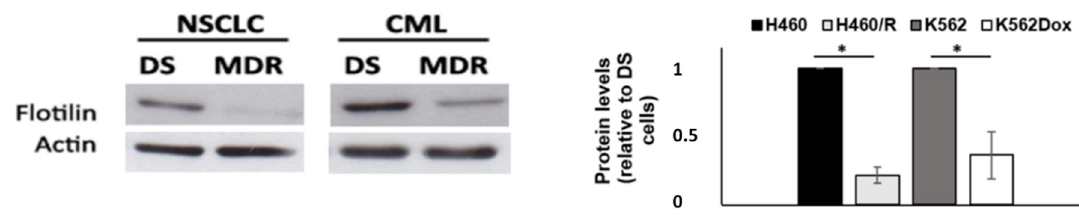
Figure 4. Analysis of expression of flotillin-1 in drug-sensitive and MDR counterpart cells. Comparison of the levels of flotillin-1 between DS (NCI-H460 or K562) and MDR (NCI-H460/R or K562Dox) counterpart cells, analyzed by Western blot. Left panel: representative images of blots from at least 3 independent experiments; right panel: densitometry analysis expressed after normalization of the values obtained for each protein with the values obtained for actin (and further expressed in relation to DS cells). Results represent the mean ± SEM from at least three independent experiments. * p ≤ 0.05.